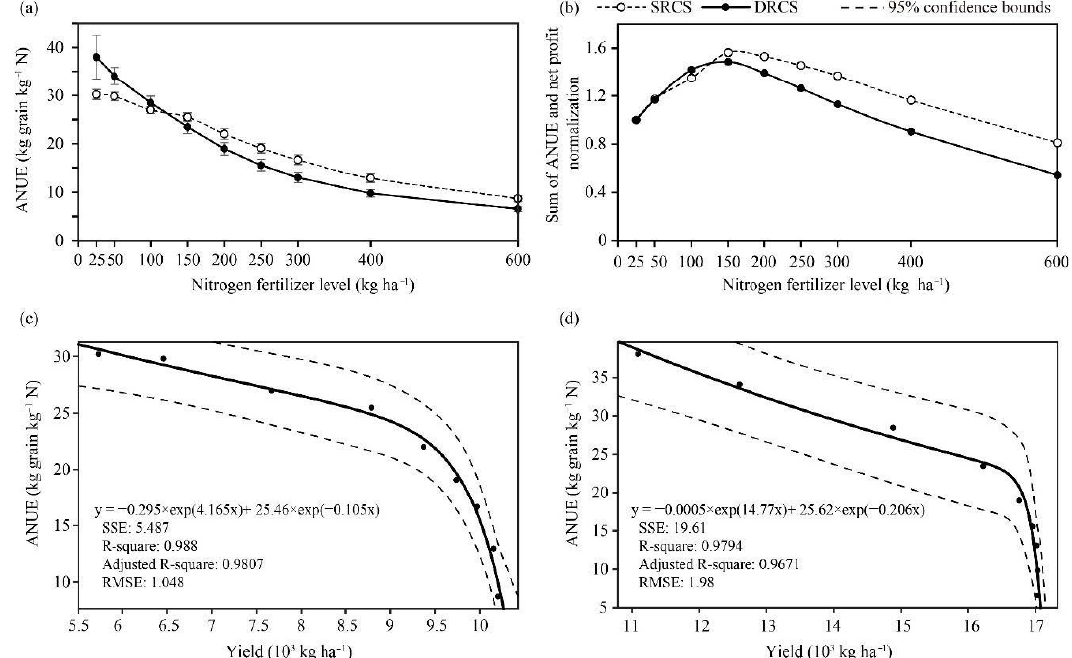
Figure 6. Relationships between agronomic nitrogen use efficiency (ANUE) and nitrogen fertilizer levels, rice grain yield, and net profitfor SRCS and DRCS in the study region. Note: Dotted lines are the 95% confidence bounds. ( a ) ANUE vs. nitrogen fertilizer level for SRCS and DRCS. ( b ) Sum of ANUE and net profit normalization vs. nitrogen fertilizer level for SRCS and DRCS. ( c ) ANUE vs. rice grain yield for SRCS. ( d ) ANUE vs. rice grain yield for DRCS.